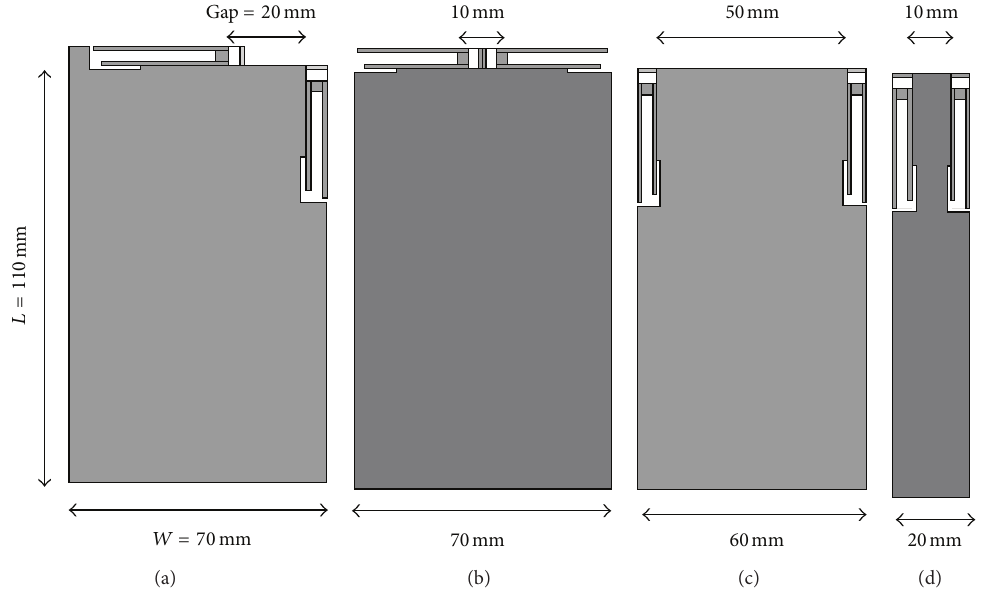
Figure 2: Antenna location and arrangement; (a) case 1, (b) case 2, (c) case 3, and (d) case 4.